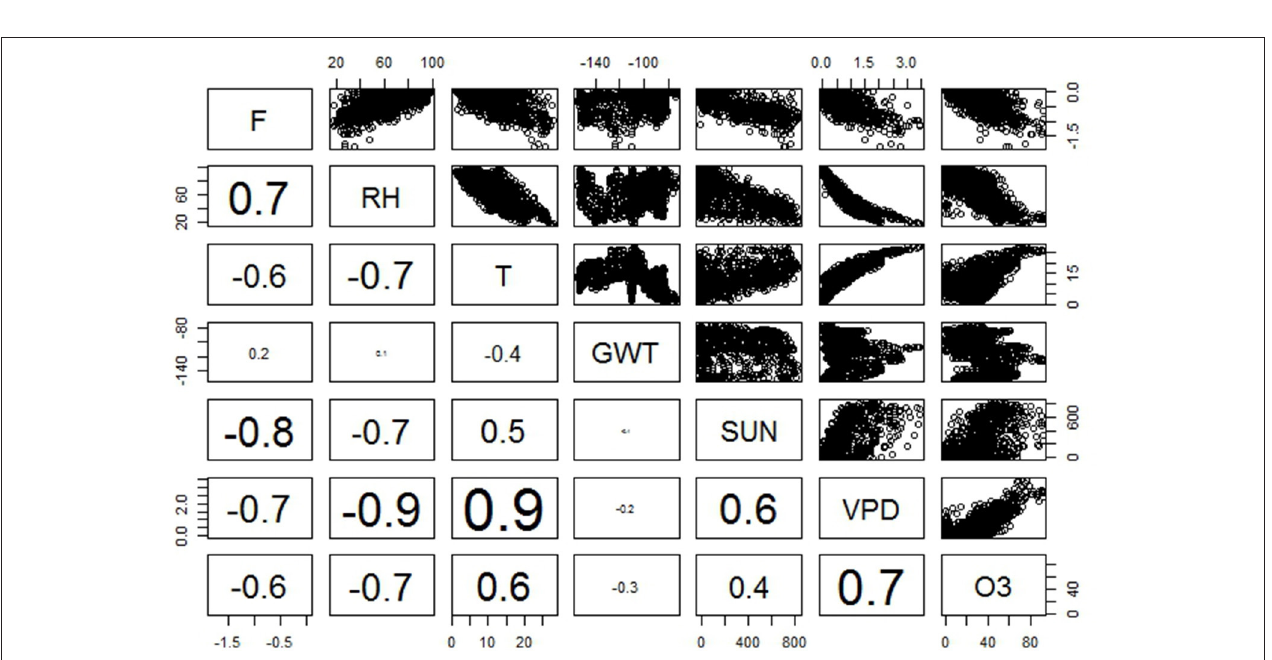
FIGURE 11 | Pairplot of half-hourly ozone flux ( F , ppb m s − 1 ) and covariates measured over the period 20 March to 9 May 2007. The upper panel contains scatterplots while the lower panel depicts the estimated pair-wise Pearson correlations using a font size which is proportional to the absolute value of the estimated correlation